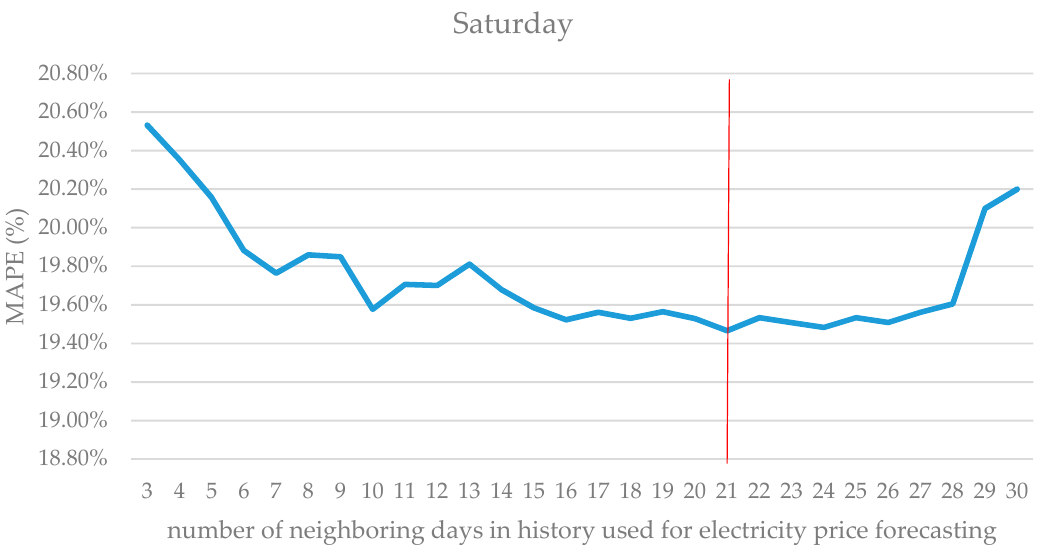
Figure 11. Correlation between price forecasting error and the size of a similar day data set for Saturday.